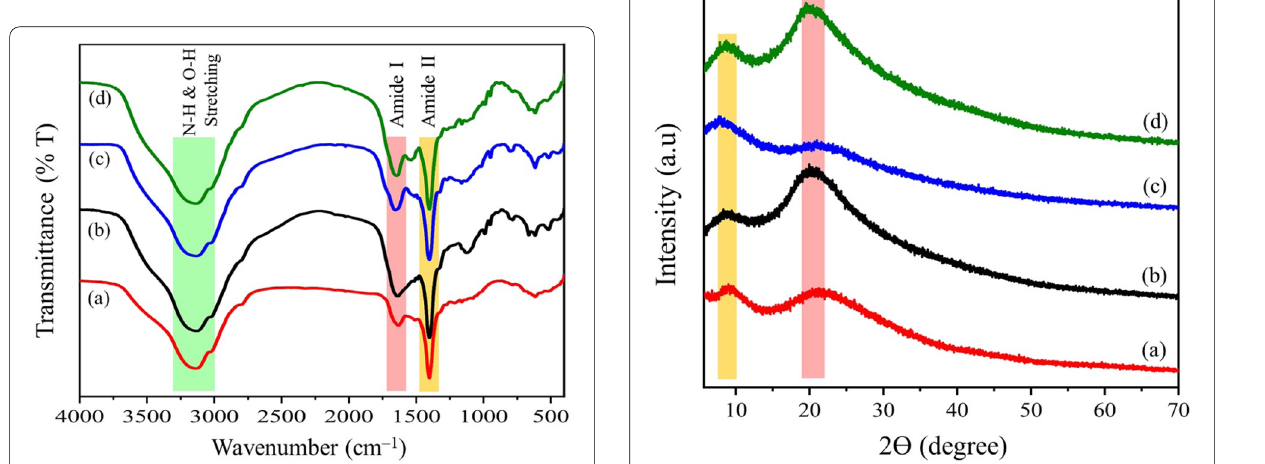
Fig. 1 FT-IR spectra of a standard wool keratin and keratin isolated from waste, b animal wool, c human hair, d chicken feather